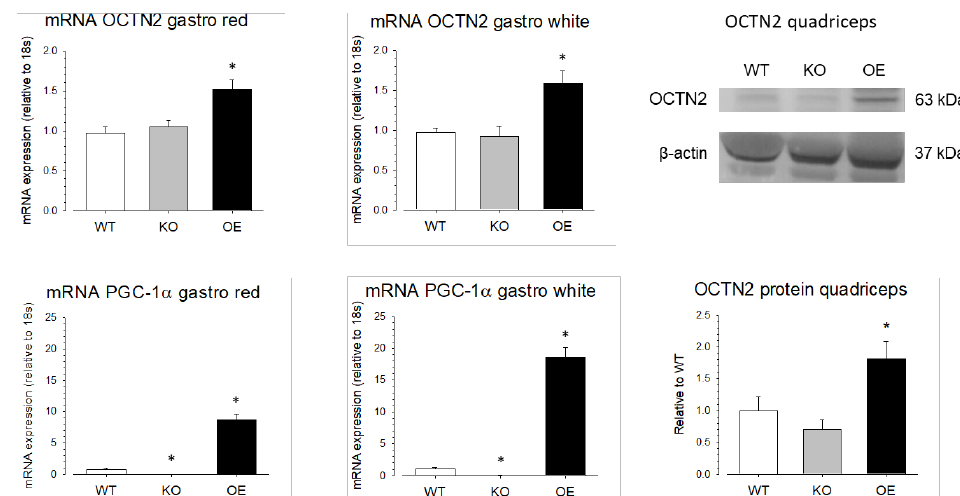
to WT and KO mice.